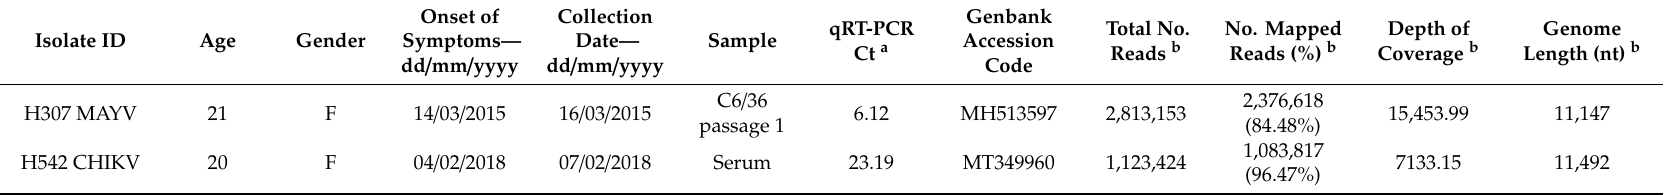
Table 1. Epidemiology and sequencing data of two alphaviruses obtained from patients living in Sinop,